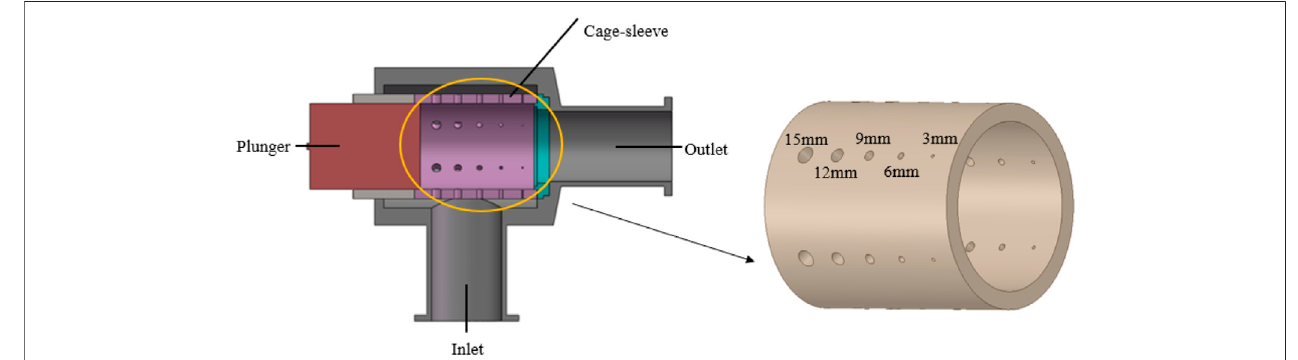
FIGURE 4 | Diagram of the cage-sleeve throttling valve structure.